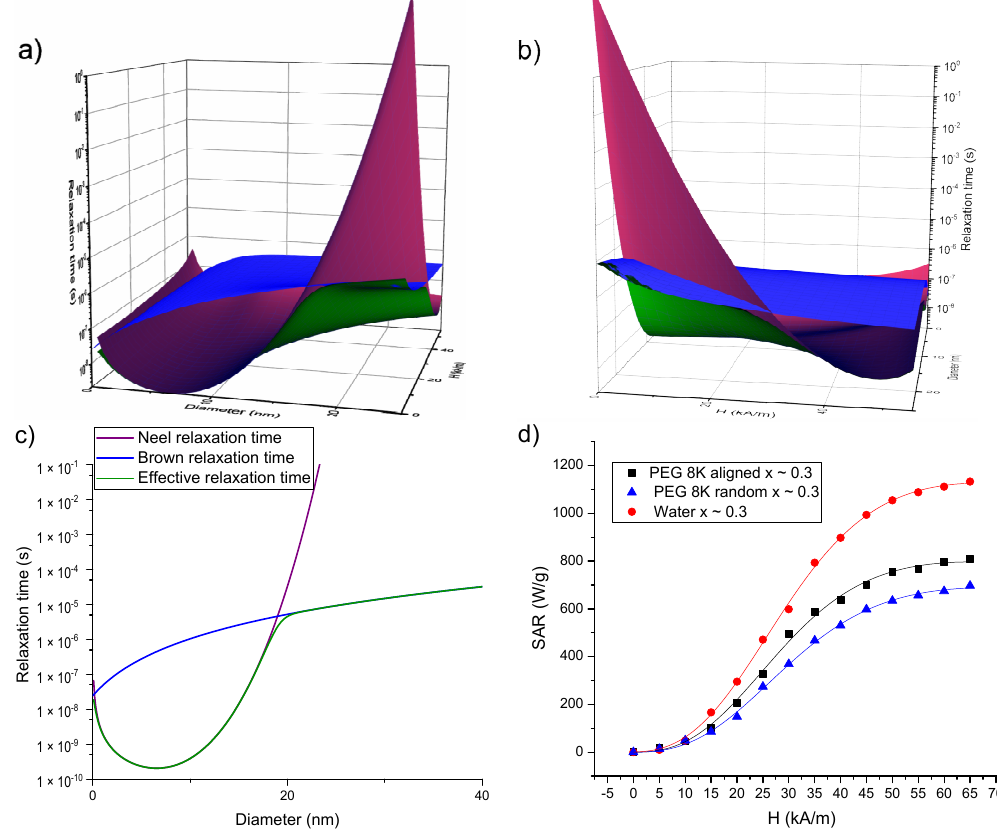
Figure 8. ( a – c ) Dependence of the Brown (blue), Neel (purple) and e ff ective (green) relaxation times on the MNPs size and AMF amplitude. In ( a ) the plane showing the time dependence on the MNP size can be compared with the well-known size dependences of the relaxation times in the absence of the field ( c ). In ( b ) one can notice that both Brown and Neel relaxation times decrease by increasing the AFM amplitude, but the dependence on the AFM amplitude is steeper for the Neel relaxation time. ( d ) Fitting the experimental SAR data (dots) of the samples with x ~ 0.3 with a fitting function (lines) given by Equation (12), which takes into account the dependence of both Neel and Brown relaxation times on the AMF